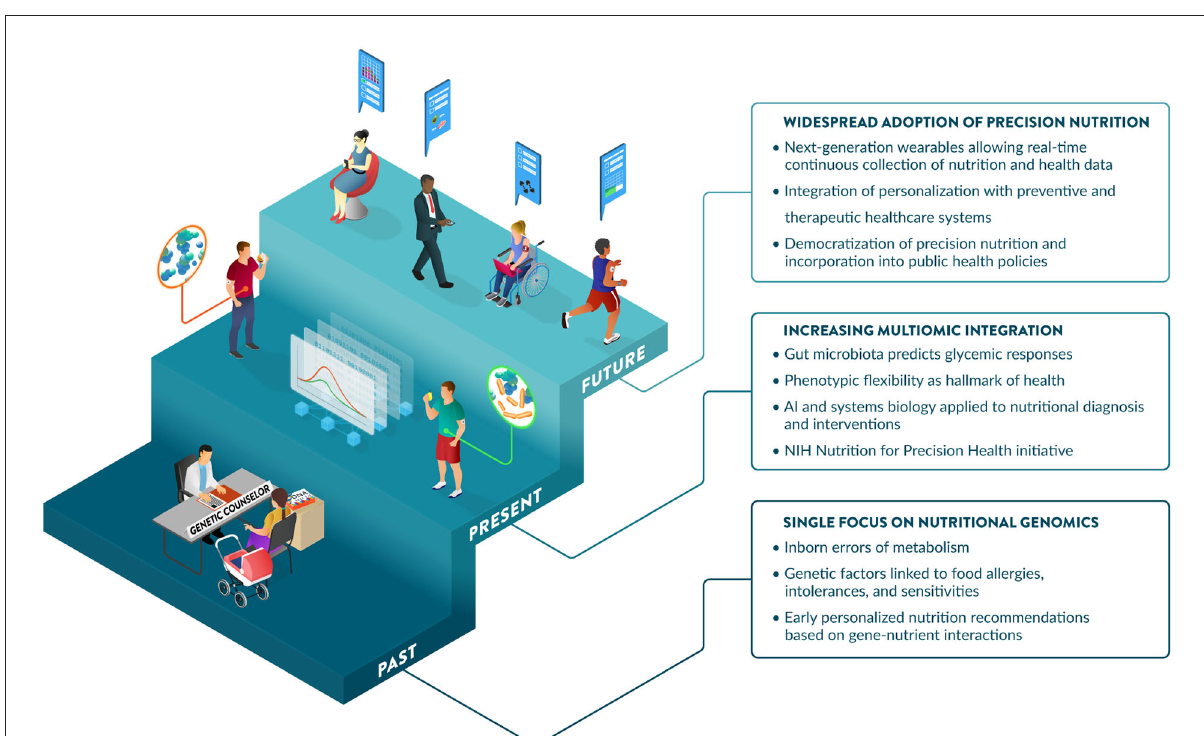
FIGURE4 The past, present, and future of Precision Nutrition. The origins of PN are linked to the discovery of inborn errors of metabolism and later more prevalent gene-diet interactions affecting nutrient metabolism and requirements. The contributions of nutritional genomics to PN are complemented by additional omic and input layers, providing increased predictive power of diet-related outcomes, including glycemic responses. In addition to traditional markers measured in the fasting state, insights from dynamic postprandial responses strengthen the importance of phenotypic flexibility, which is now considered a hallmark of health. Large-scale initiatives from NIH and elsewhere are refining systems biology approaches and AI-driven tools to integrate data layers, predict outcomes, and derive effective dietary recommendations tailored to the biology, environment, and specific needs of individuals. The future may offer increased opportunities for the adoption of PN, enabled by wearables that provide a user-friendly and seamless collection of dietary and health data, which will be leveraged by healthcare to lower costs and improve population health, aided by public health